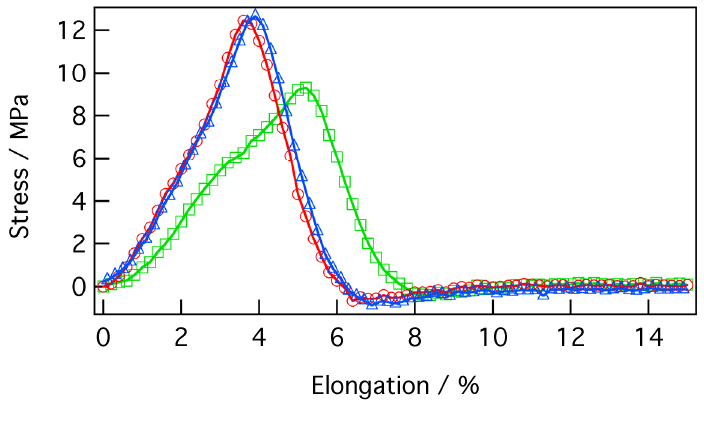
Figure 9. Stress–strain curve of a P3HT/PMMA composite film. Red and blue lines show standard measurement data, while the green line was obtained from a sample, which exhibited partial rupture during